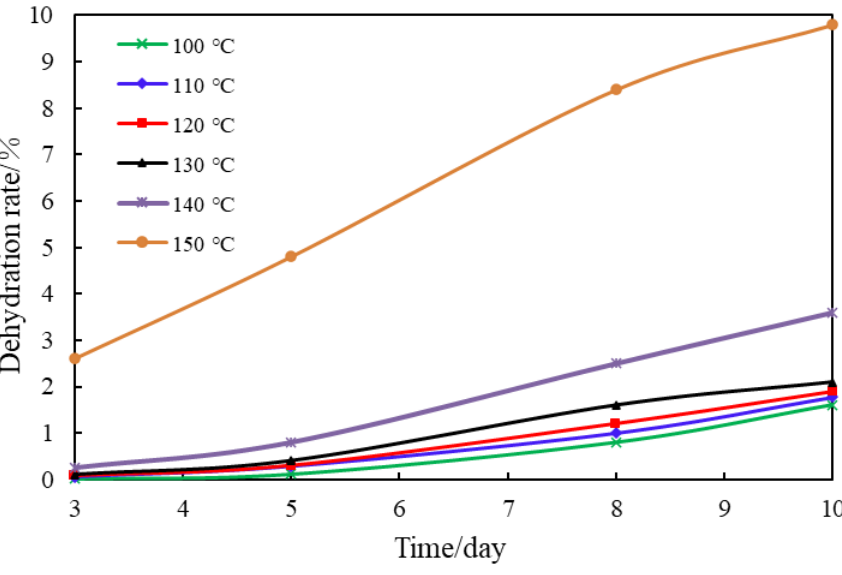
Figure 7. Effect of Temperature on the Gel Dehydration Rate.